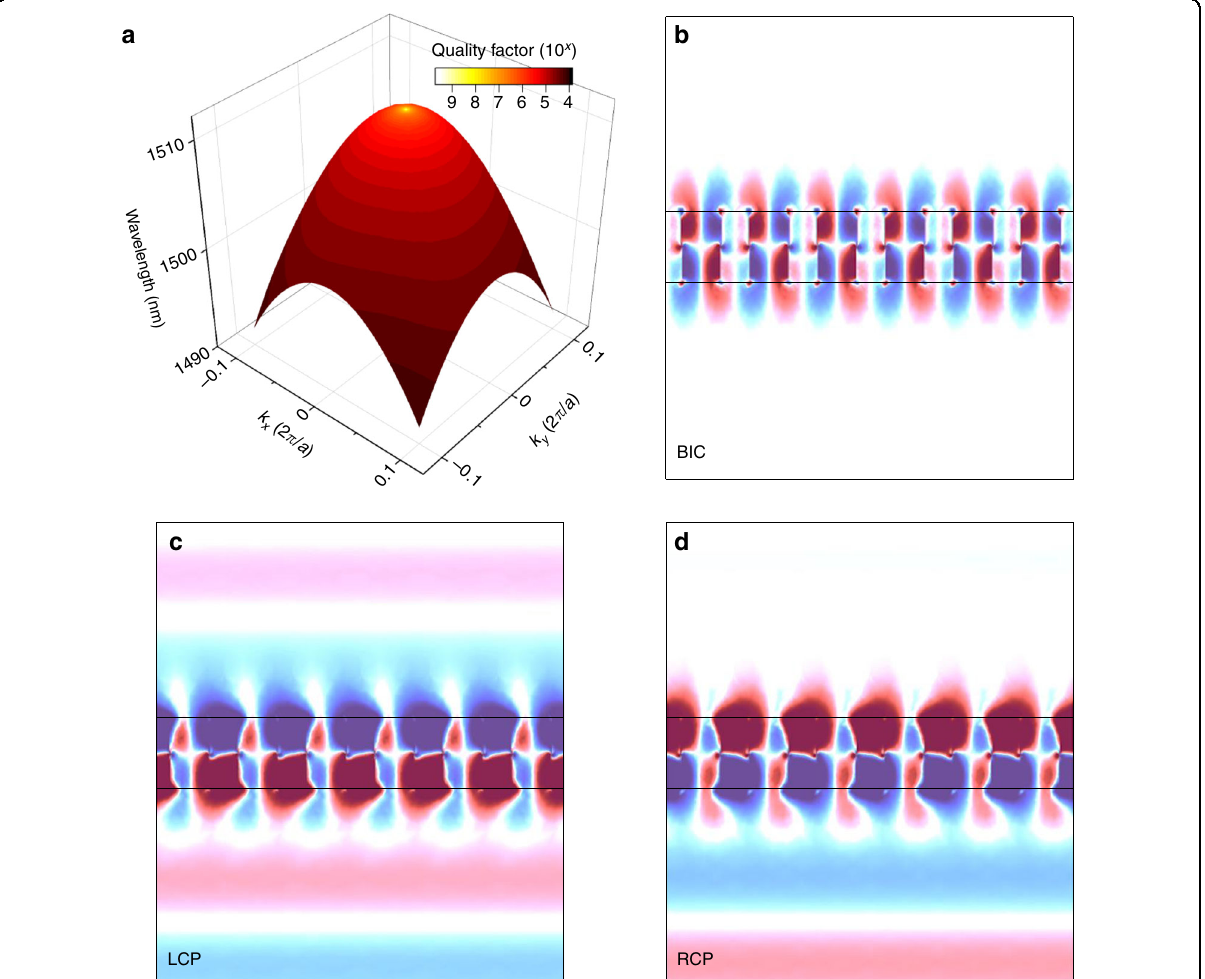
Fig. 2 Simulated results of the twisted PhCS supporting BIC with α top = 18° and α bot = 0°. a Iso-frequency surface and color-mapped quality factor of the twisted PhCS. A symmetry-protected BIC is induced at Γ point. b Field distribution of the twisted PhCS at Γ point. c Left circular polarized fi eld and d right circular polarized fi eld at off − Γ point, showing the chiral features of the twisted